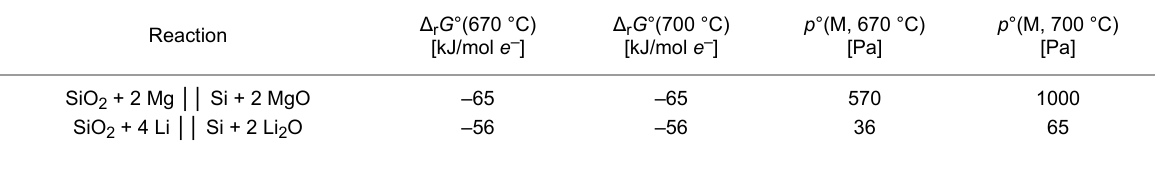
Table 1: Properties of the metals M = Mg and M = Li of relevance to the thermal reduction of SiO 2 : standard Gibbs free energies of the reactions and metal vapor pressures at two different temperatures [22].